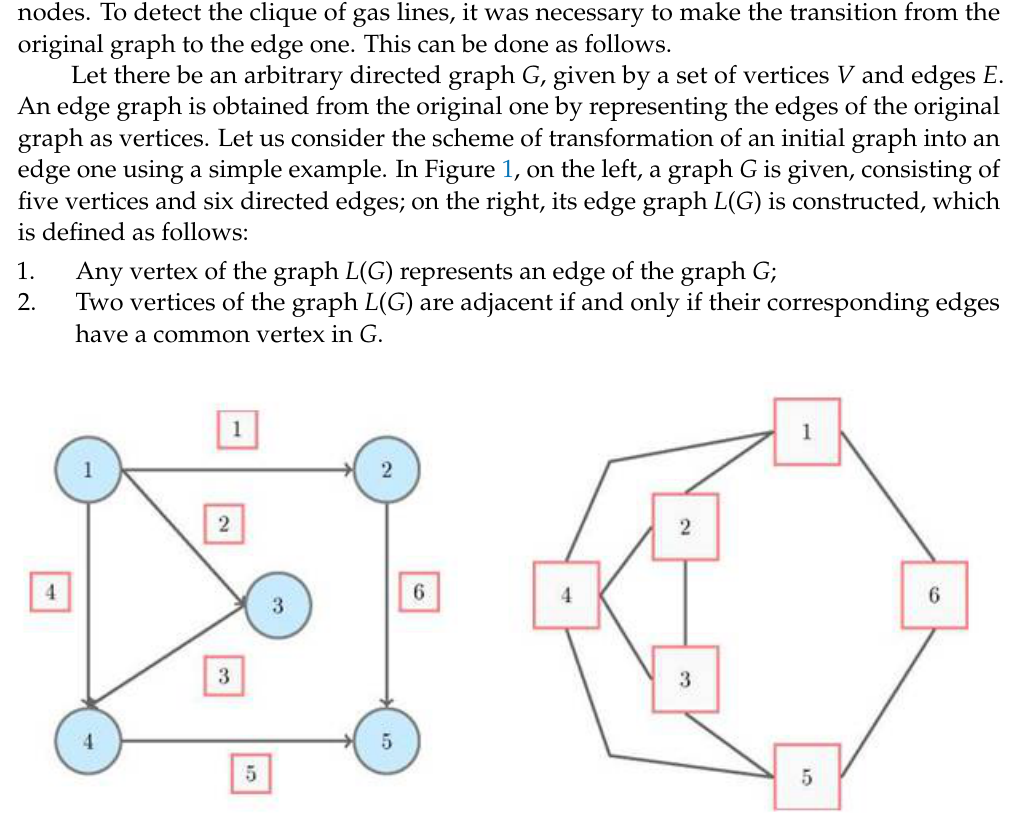
Figure 1. Original graph (left) and edge graph (right).